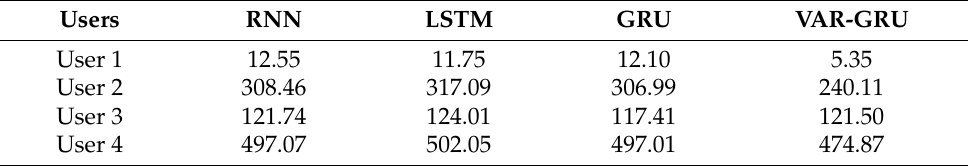
Table 3. Mean absolute error value (MAE) for all of the techniques.